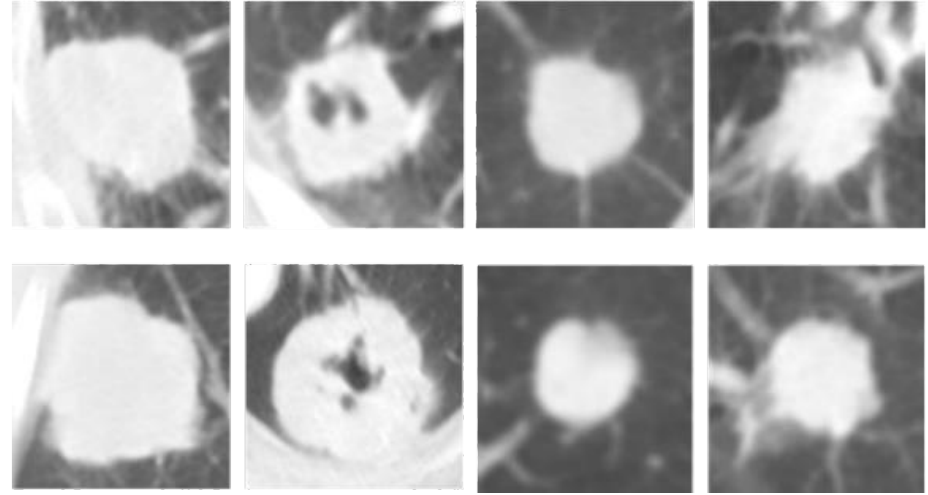
Figure 1. Examples of lung tumors with similar appearance between recurrence and non-recurrence. Non-recurrence tumors are in the first row, and recurrence tumors are in the second row. Several studies have used radiomic features to predict the prognosis of lung cancer patients using CT images, and these studies can be categorized into those that investigate only the intratumoral region or both the intratumoral and peritumoral regions [12–20]. In a radiomics study using intratumoral region information, Coroller et al. [12] predicted distant metastasis (DM) of lung adenocarcinoma patients at stages II–III who were treated with radiation. In their study, 635 radiomic features were used, including those based on the intensity, texture, shape, a Laplacian of Gaussian (LoG) filter, and a wavelet filter. Their findings demonstrate that the features of the texture heterogeneity and intensity skewness of the LoG and the wavelets are strongly associated with DM in patients. Coroller et al. [13] predicted the level of the pathological response of patients at stages II-III who underwent neo-adjuvant chemotherapy and radiotherapy before surgery. In that study, 1603 radiomic features were used, including intensity, texture, shape, LoG-filter-based, and wavelet-filter- based features. The study, in this case, showed that the spherical shape of the tumor is important when attempting to predict the pathological response to chemo-radiotherapy. Cong et al. [14] predicted lymph node metastasis in patients at stage IA who underwent cu- rative resection surgery. In this study, 396 radiomic features were used, including intensity, texture, and shape features, indicating that significant features, such as the uniformity of the gray-level co-occurrence matrix and tumor homogeneity, provided predictive information about lymph node